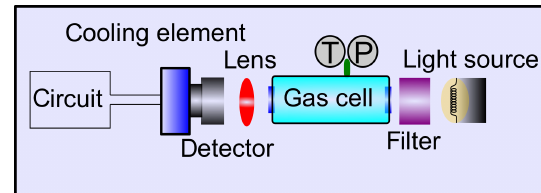
Figure 3. Schematic setup for detection of individual carbon oxides in civilian